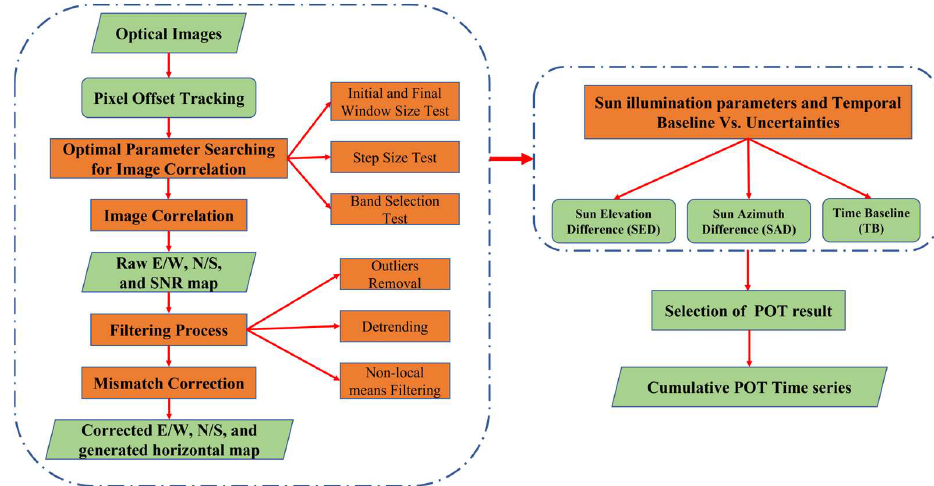
Figure 3. Pixel offset tracking (POT) post-processing flowchart.